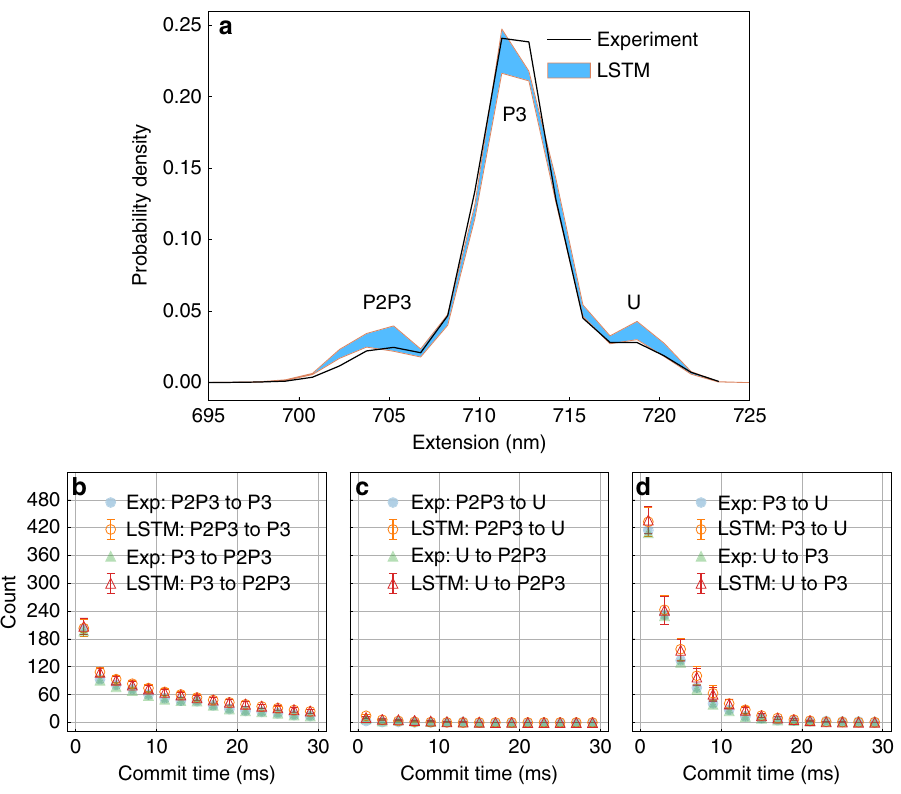
Fig. 6 Boltzmann statistics and kinetics for riboswitch. Using LSTM model to learn thermodynamics and kinetics from a folding and unfolding trajectory taken from a single molecule force spectroscopy measurement 20 : a Comparison between the probability density learned by the LSTM model and calculated from the experimental data. The regions between errorbars de fi ned as standard errors are fi lled with blue color. b – d Commit time plots calculated by counting the transitions in the trajectory generated by LSTM and the experimental trajectory. The commit time is the minimum time that must be spent by the trajectory in a given state to be classi fi ed as having committed to it. Error bars are illustrated and were calculated as standard errors.